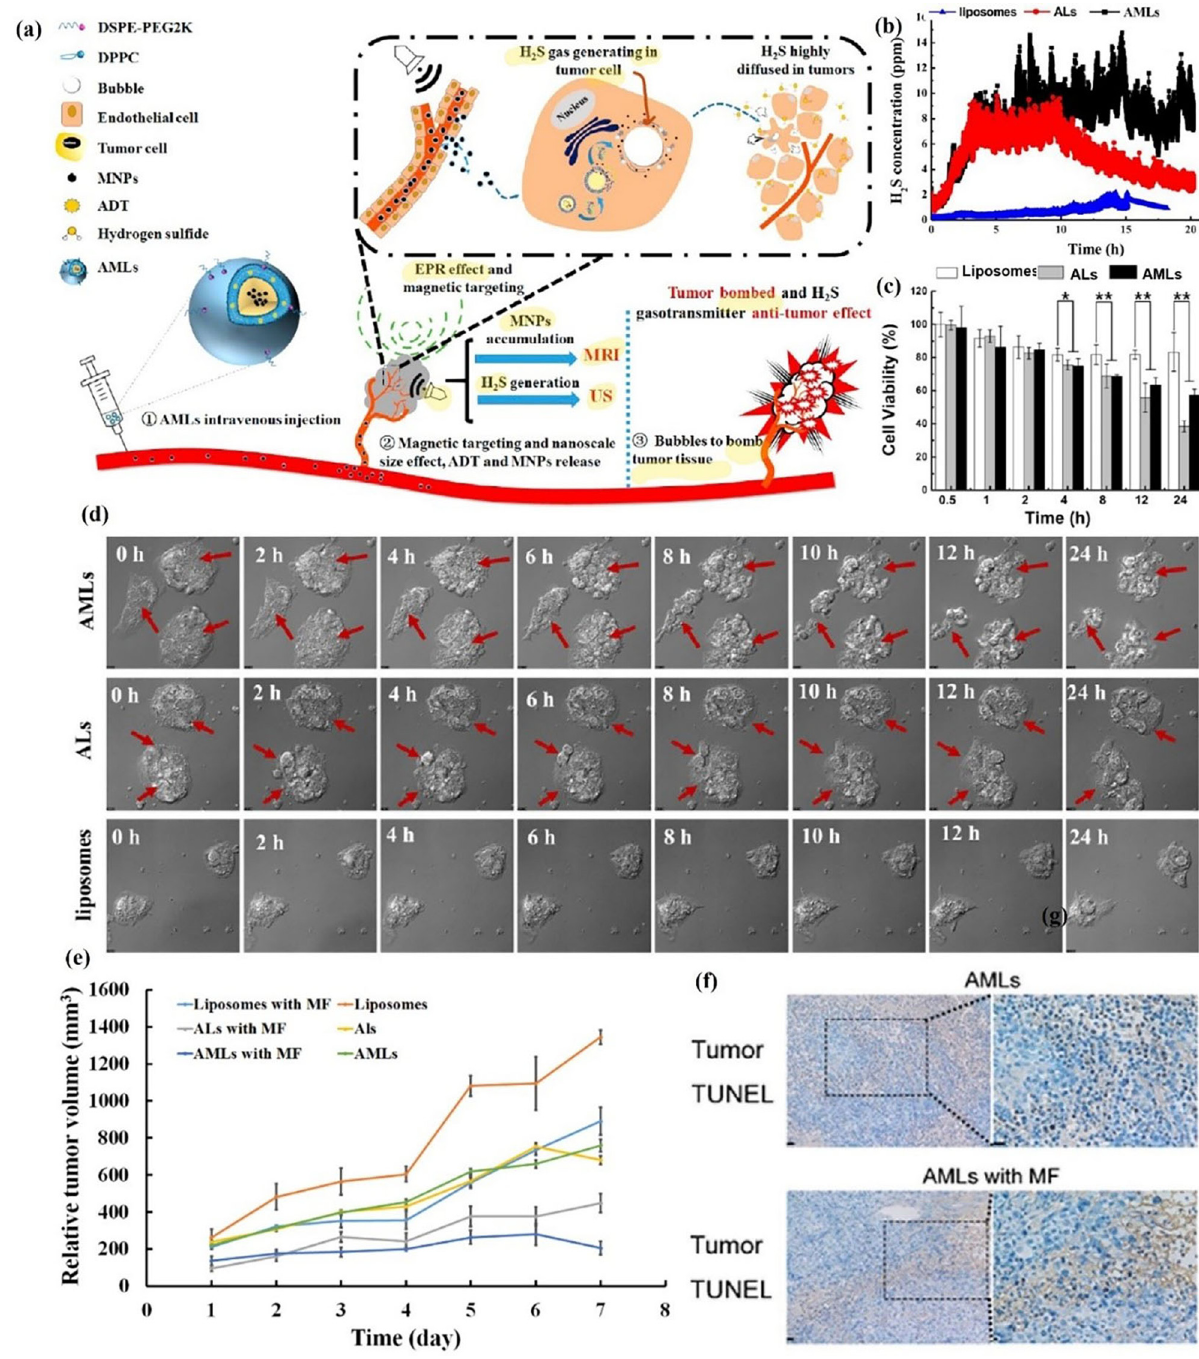
Figure 12: ( a ) Schematic illustration of the composition and mechanism of actions of AMLs. ( b ) Detection of H 2 S production by di ff erent treatment groups. ( c ) Cell viability in di ff erent treatment groups at di ff erent time points. ( d ) Changes in cell morphology and bubble generation at 0, 2, 4, 6, 8, 10, 12, and 24 h in AMLs, ALs, and liposome groups. The presence of bubble and cell membrane damage was indicated by red arrows. ( e ) The changes of relative tumor volume throughout the 7 day follow - up treatment of di ff erent groups. ( f ) TUNEL assay for tumors. Reprinted with permission from Ref. [ 79 ] ; Copyright © 2017 American Chemical MR images did not show a decrease in the T2 signal of blank liposomes and ADT - encapsulated liposomes ( ALs ) groups cells. Owing to the ability of AML to act as a contrast media, S production was achieved and monitored by US. The T2 after injection. While a 22% of reduction in the mean gray H 2